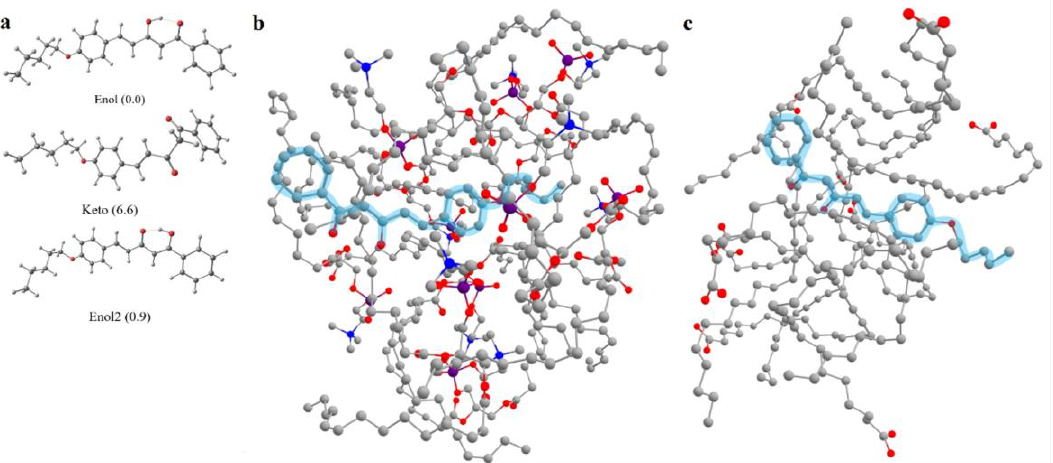
Figure 3. ( a ) Structures of the most energetically stable conformers of the simplified model of HCur and their relative Gibbs free energies (ΔG/kcal ·mol −1 , in parentheses) computed with the use of CENSO protocol for chloroform solution. ( b , c ) Optimized structures of cluster HCur -PC and HCur -PCDA obtained by MD simulation, where hydrogen atoms are omitted for clarity.